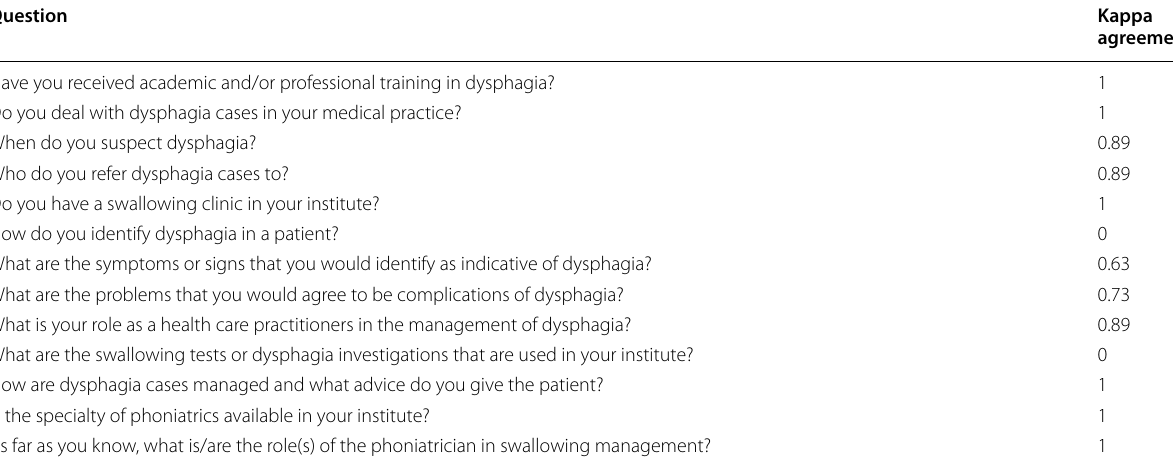
Table 9 Test-retest reliability of responses of the participants to the